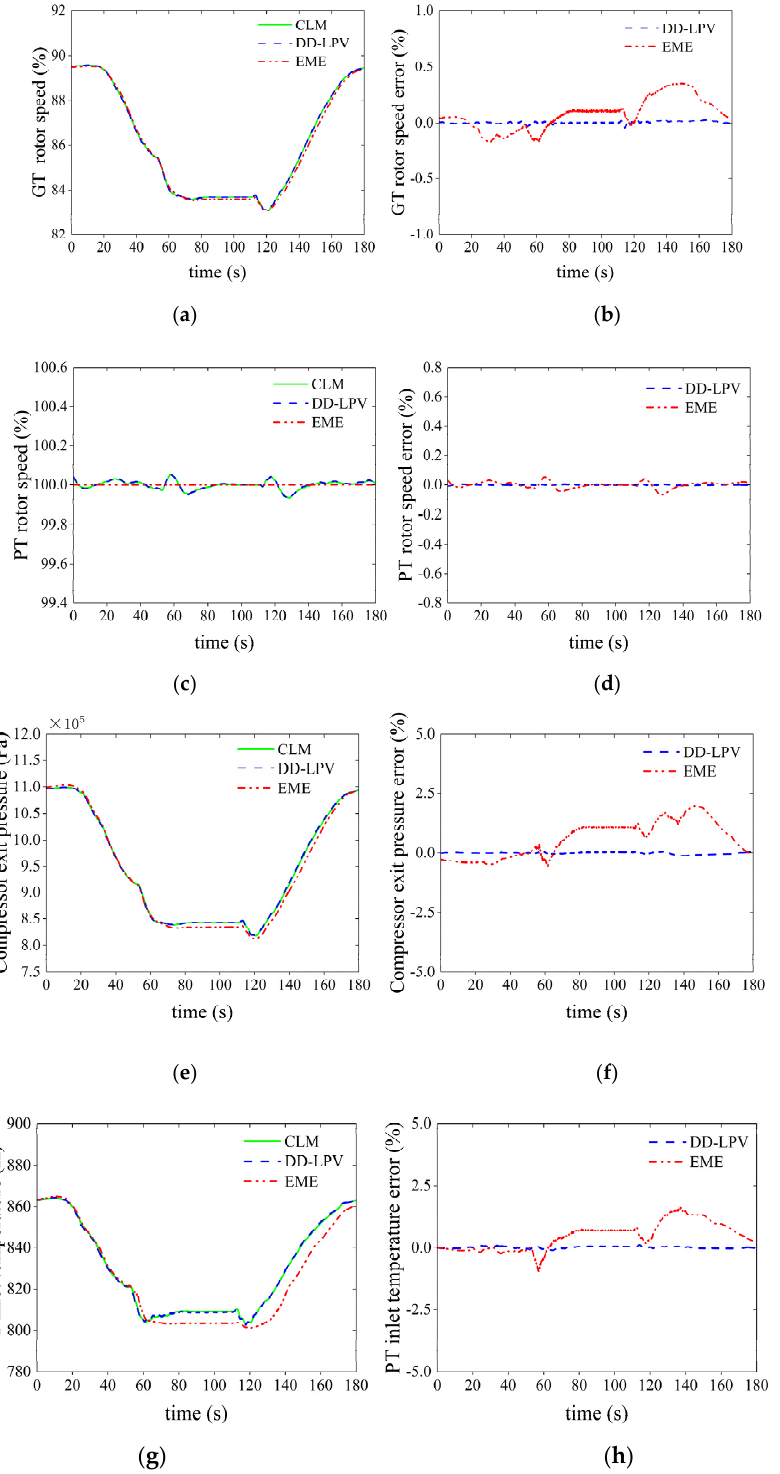
( d ) Figure 6. Parameter variations of DD-LPV model (at 1000 m, without measurement noise). ( a ) Entries of matrix A . ( b ) Entries of matrix B ( c ) Entries of matrix C . ( d ) Entries of matrix D .